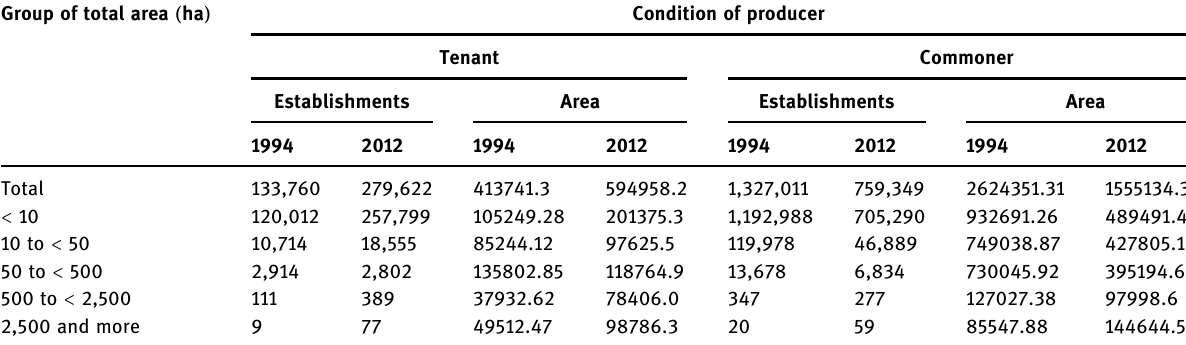
Group of total area ( ha )